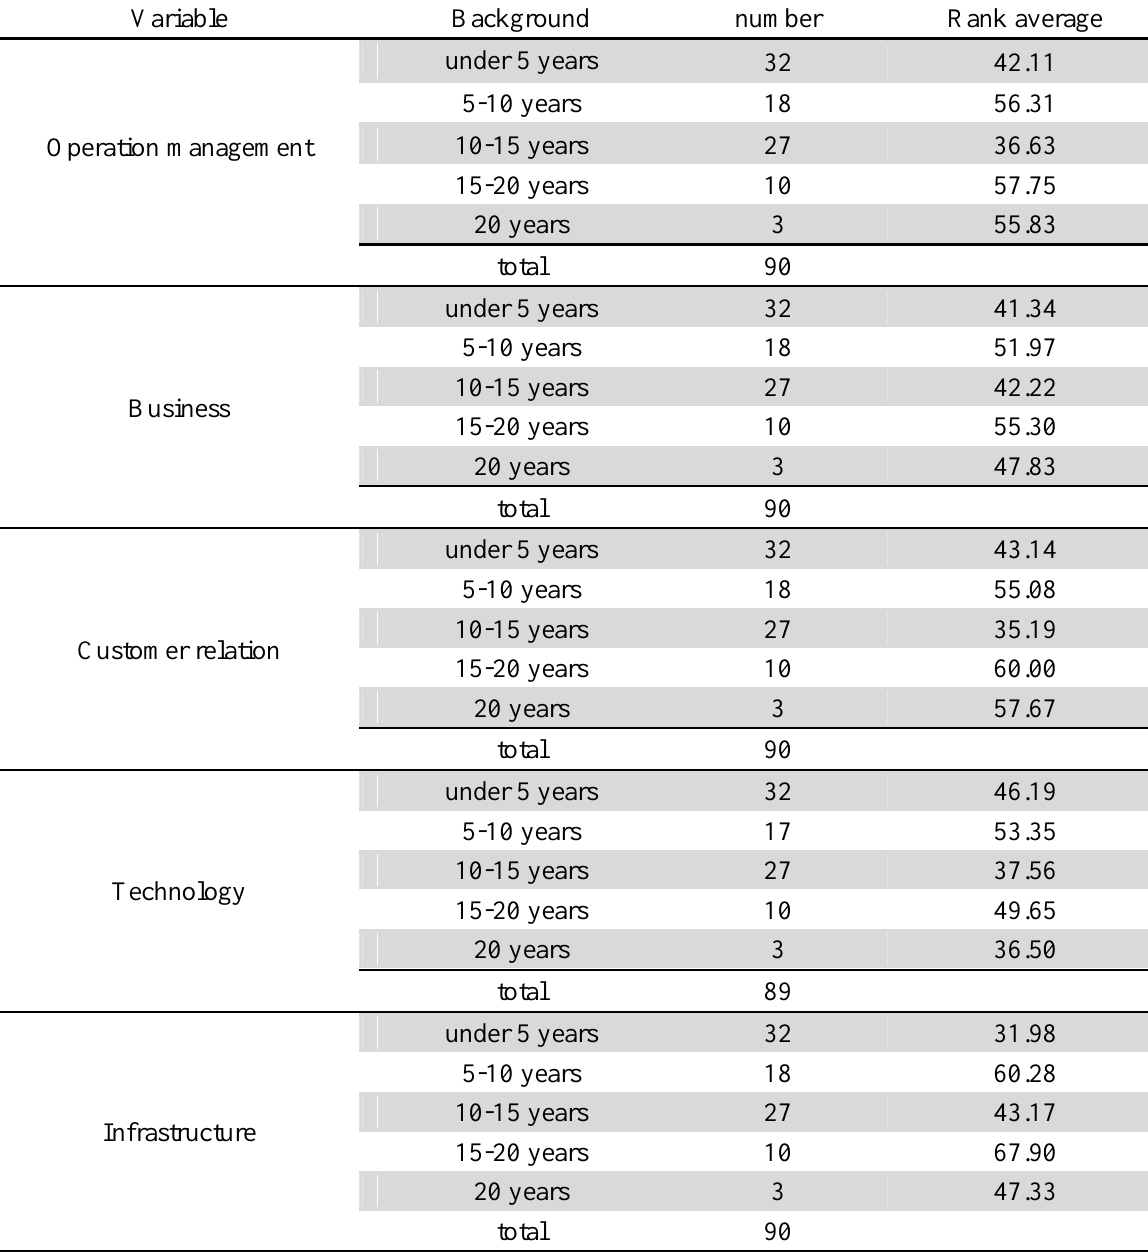
Indicates the rate with regards to the difference between comments Variable